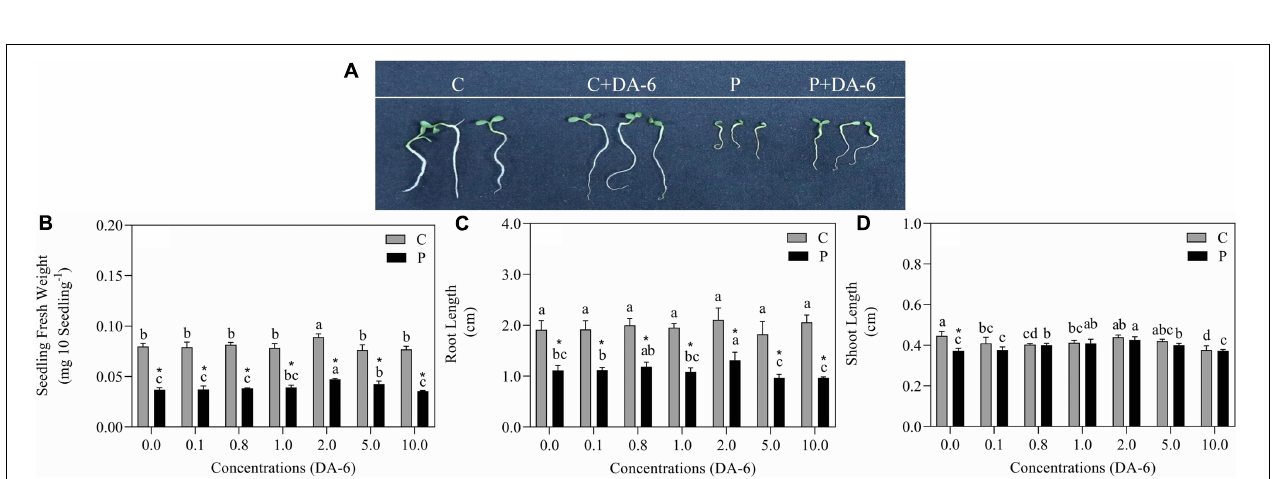
FIGURE 2 | Effect of seed priming with different concentrations of DA-6 on (A) phenotypic change, (B) seedling fresh weight (FW), (C) root length (RL), and (D) shoot length (SL) after 7 days of germination in white clover under well-watered condition and drought stress. Different letters represent significant differences among treatments with the application of different concentrations of DA-6 under well- watered condition or drought stress ( p ≤ 0.05). Vertical bars show the ± SE of mean ( n = 4), whereas * indicates significant difference between well-watered condition and drought stress under one particular concentration of